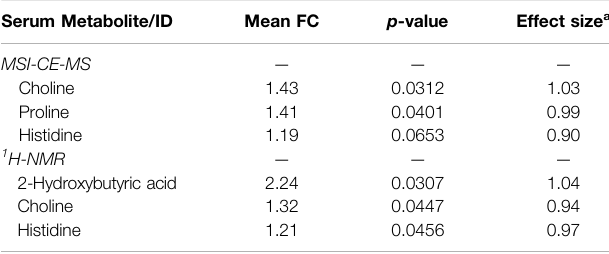
TABLE 2 | Cross-platform comparison of serum metabolites that differentiate HCVpatientswithlate(F2-F4, n (cid:1) 11)toearly-stage(F0-F1, n (cid:1) 9)liver fi brosis. Serum Metabolite/ID